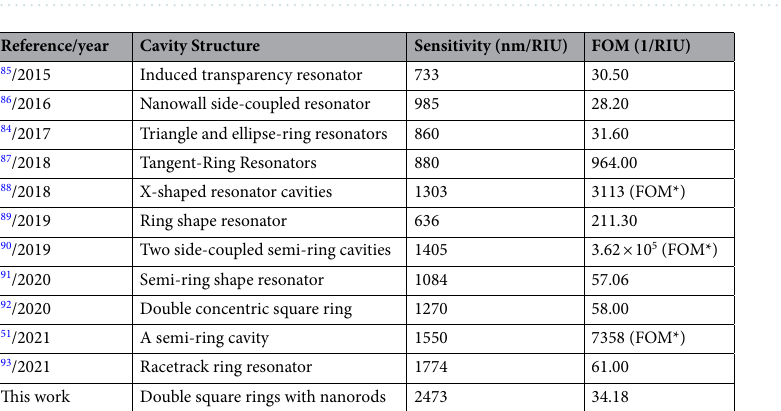
Figure 13. Time average power flow (green lines) with arrows (red arrows) of resonant fluids ( n = 1.33 as an example) around the case 3 structure from modes 1 to mode 4, respectively.